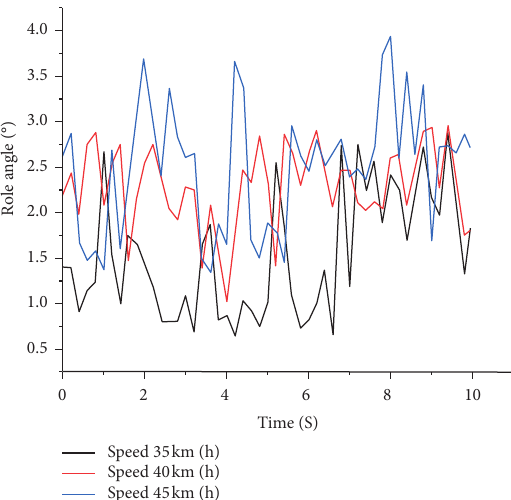
Figure 8: Roll angle change of vehicle-turning scenarios.